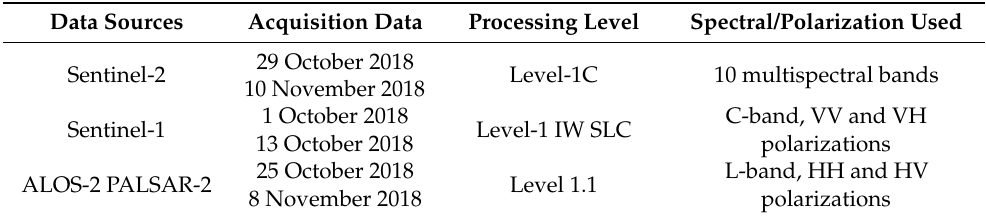
Table 2. The remote-sensing data sources used in study